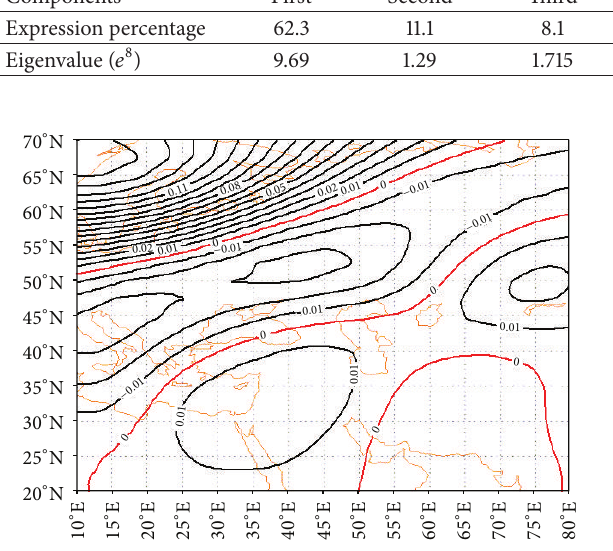
Figure 19: The second component of 500 HPa geopotential height level data.